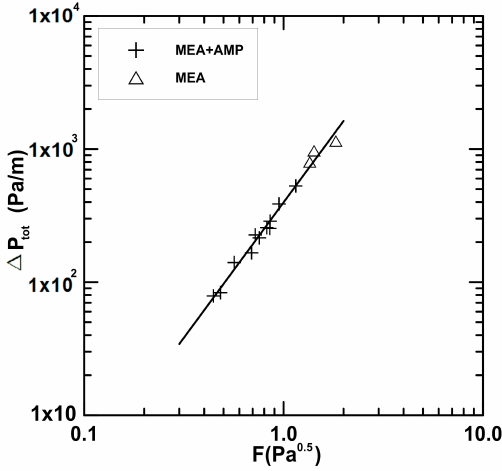
Figure 5. A plot of ∆ P tot versus F for both systems. R 2 is 0.9845, indicating the reliability of the hydrodynamic model used